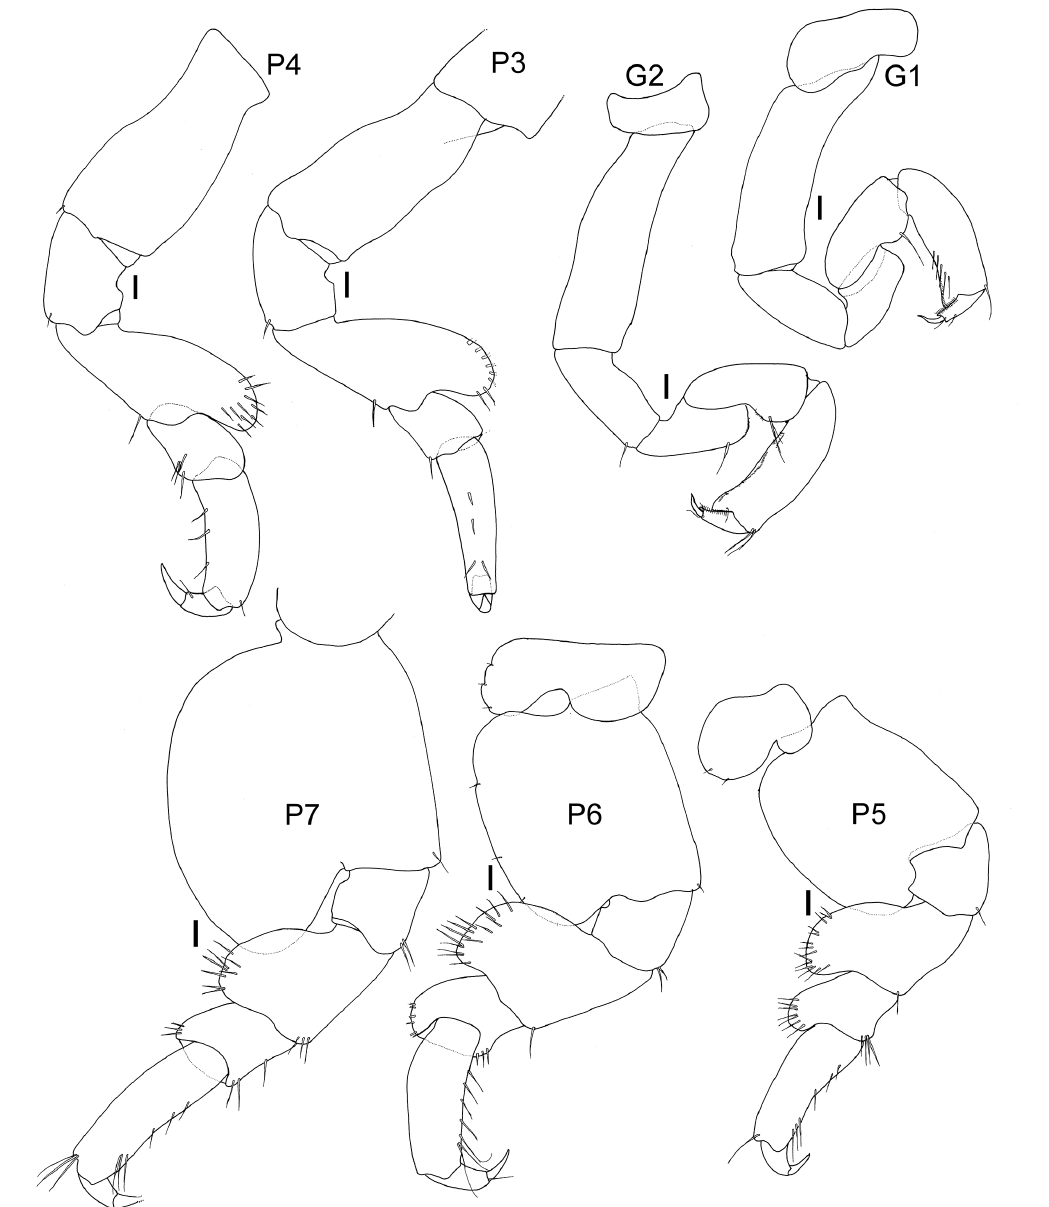
Figure 5. Bircenna thieli sp. nov. holotype female, 6 mm, AM P.100645, Bicheno, Tasmania, Australia. Scale bars: 0.1